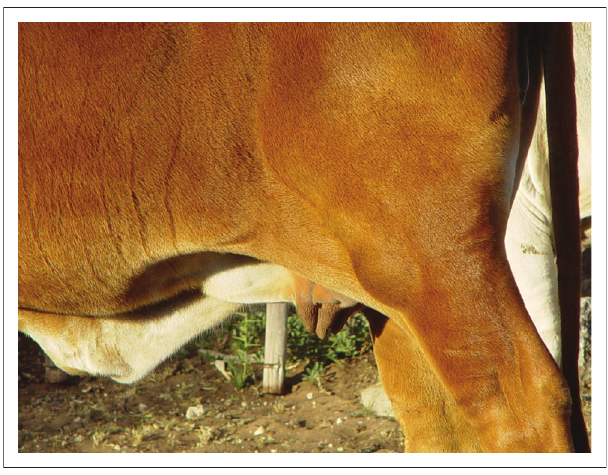
Source : Photo taken by Leon Prozesky FIGURE 1: Joint effusion of the femoro-tibial joint in a clinically affected animal with osteochondrosis.